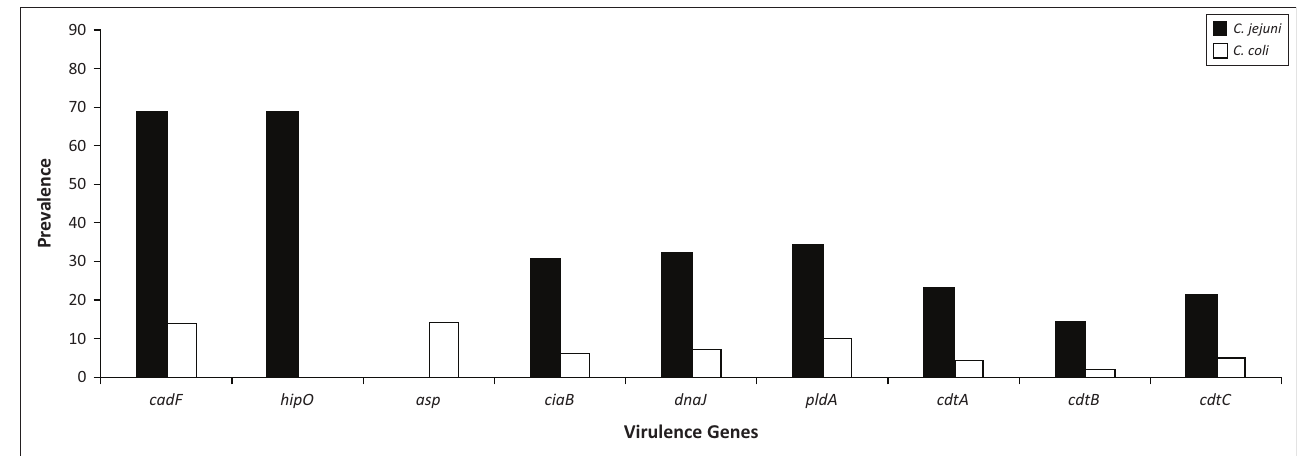
C. jejuni C. coli